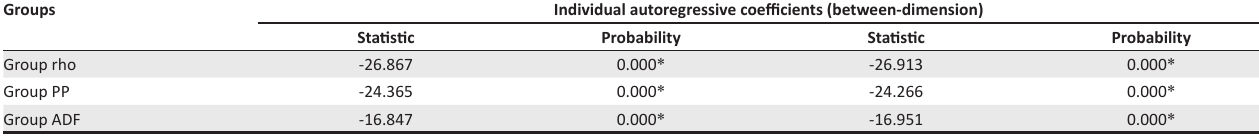
TABLE 7b: Pedroni residual cointegration test. Groups